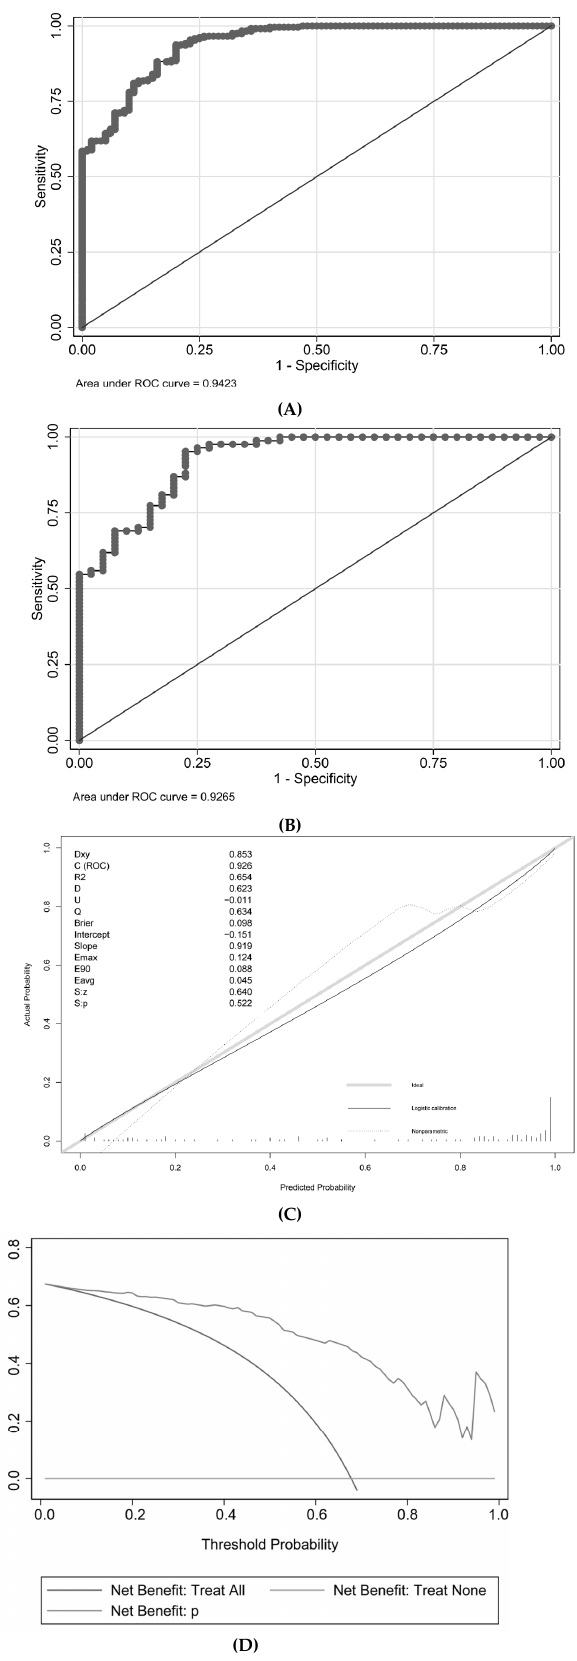
Figure 3. Discrimination, calibration, and decision curve analysis for the model. ( A ) ROC in the development cohort; ( B ) ROC in the validation cohort; ( C ) Calibration plot; ( D ) Decision Curve Analysis.